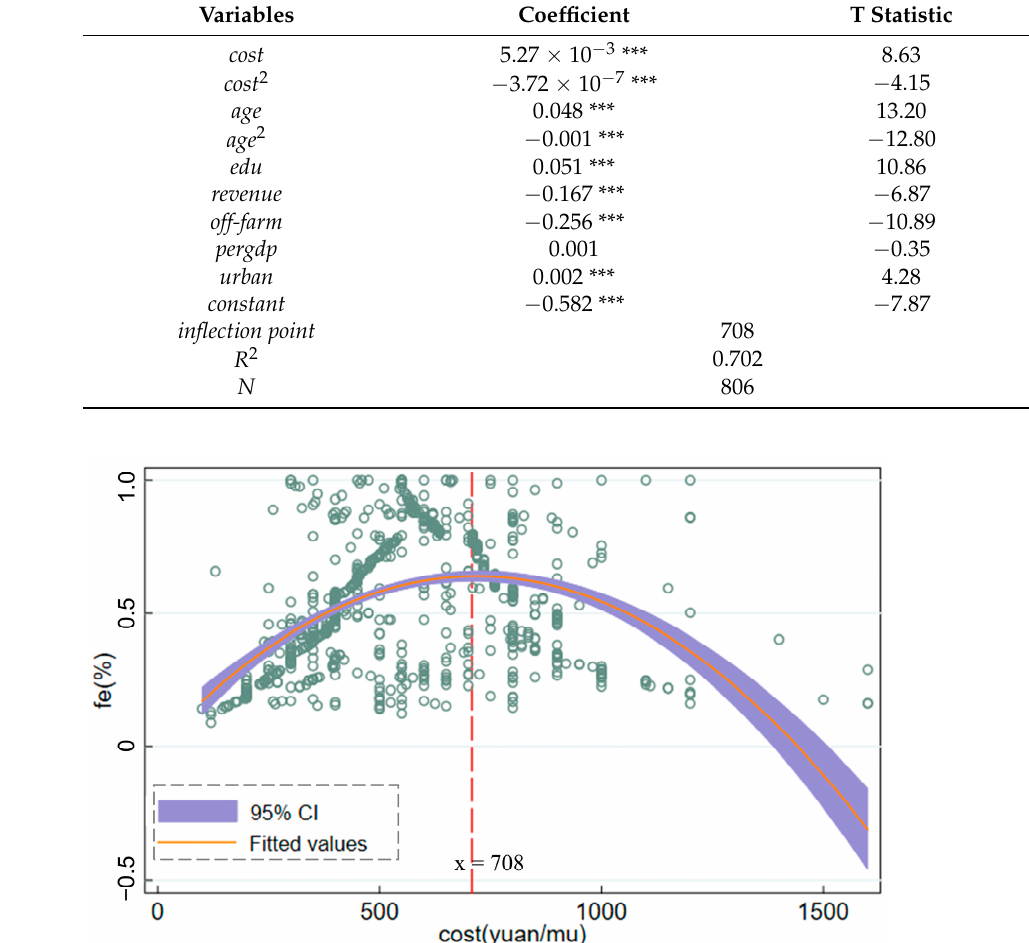
Table 2. Estimation results of multiple quadratic regression model. Note: *** indicates significance at the levels of 1%.